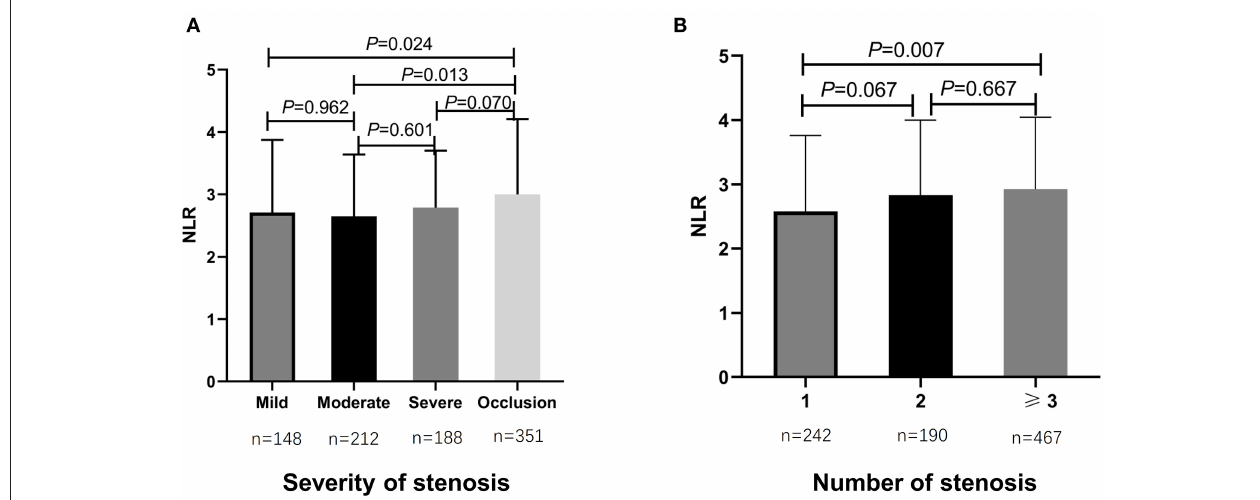
FIGURE 1 | Comparisons of admission NLR levels according to the severity and number of intracranial atherosclerotic stenosis in sICAS patients. (A) Comparison of admission NLR levels according to the severity of intracranial atherosclerotic stenosis. (B) Comparison of admission NLR levels according to the number of intracranial atherosclerotic stenosis. P < 0.05 was considered statistically significant. NLR, neutrophil-to-lymphocyte ratio; sICAS, symptomatic intracranial atherosclerotic stenosis.